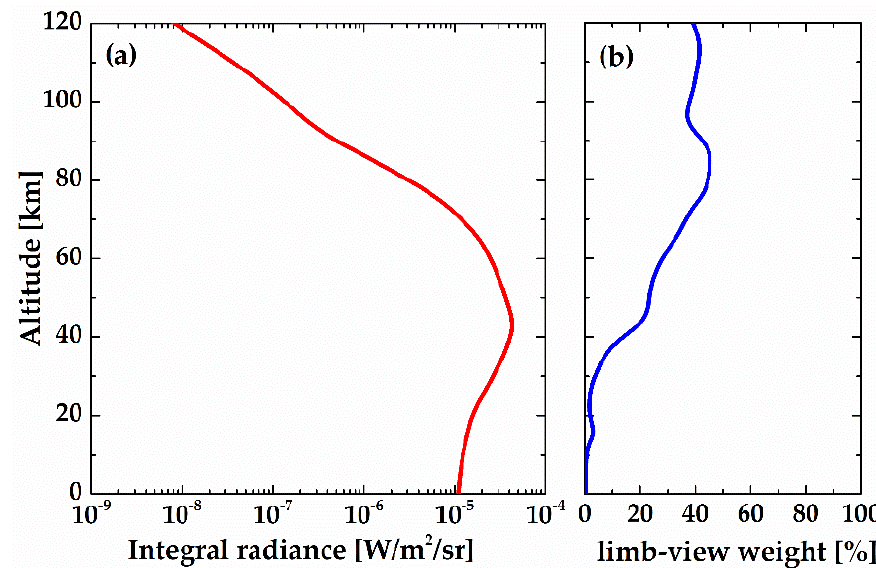
Figure 10. The integral radiance ( a ) and limb-view weight ( b ) of the R 9 Q 10 line varying with the tangent altitude.